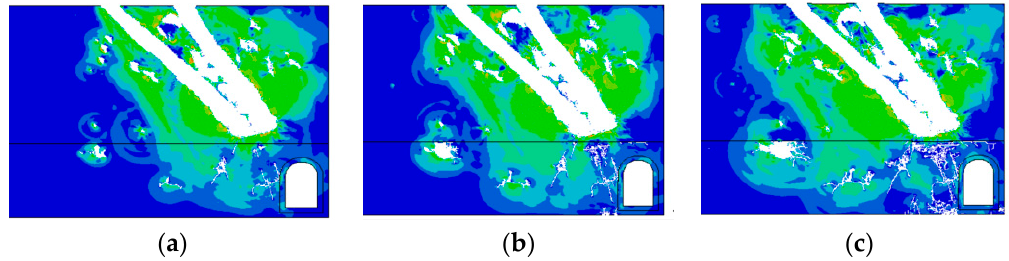
Figure 4. Development of the crack around the blast-hole: ( a ) t = 4000 μ s, ( b ) t = 6000 μ s, and (c) t = 8000 μ s.